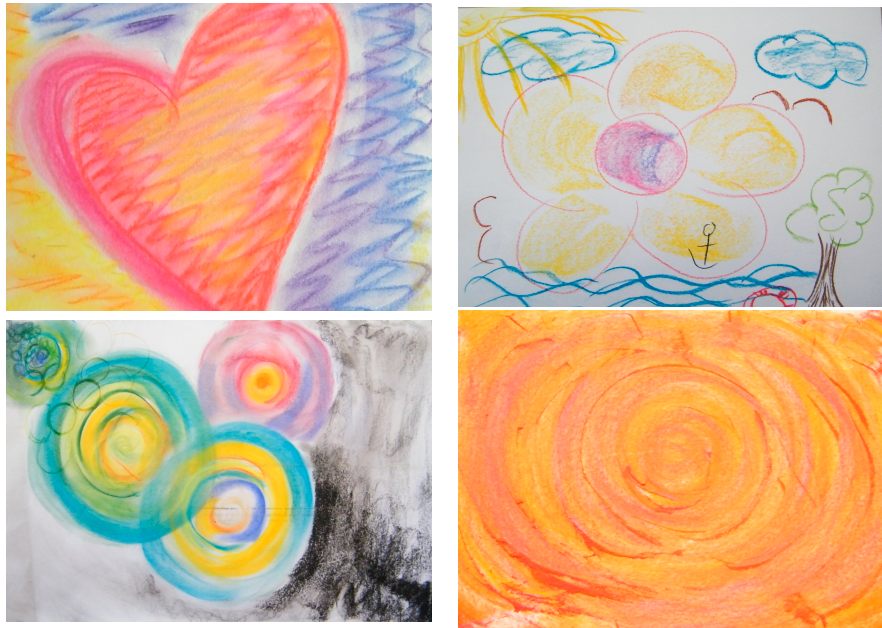
Figure 3. These photos show the first four examples/details of the creations with paper, color, and/or words that emerged from the artistic inquiry in this study.